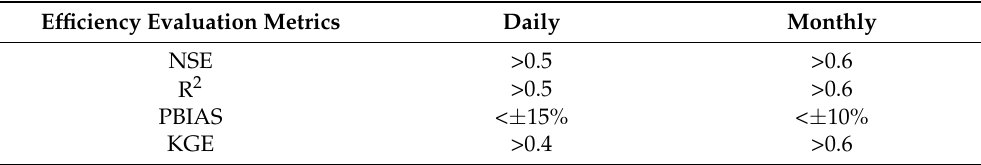
Table 1. Efficiency evaluation metrics and their ranges for selection of best performing PPs for streamflow prediction at daily and monthly timescales in Chirah and Dhoke Pathan sub-catchments. Efficiency Evaluation